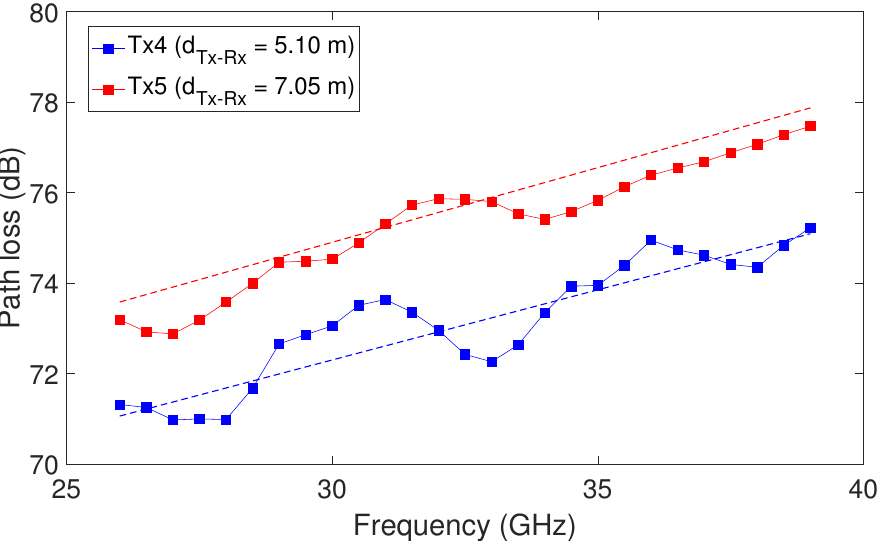
Figure 8. Path loss in terms of the frequency for Tx-4 and Tx-5 positions. The dashed lines indicate a trend obtained from a linear regression